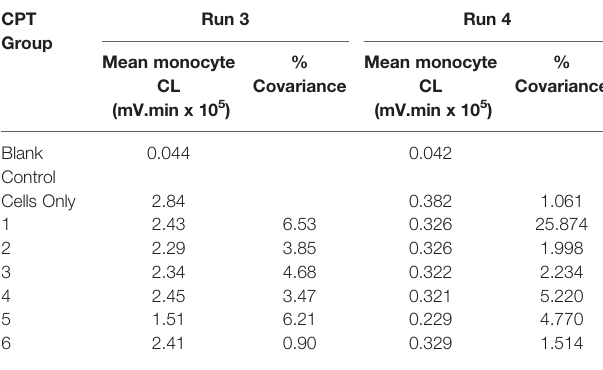
TABLE 5 | Monocyte CL for run 3 and run 4. PMA 10 -5 M, luminol 10 -6 M, 30- minutes priming and 90-minutes post-activation. CPT Run 3 Run 4 Group Mean monocyte CL